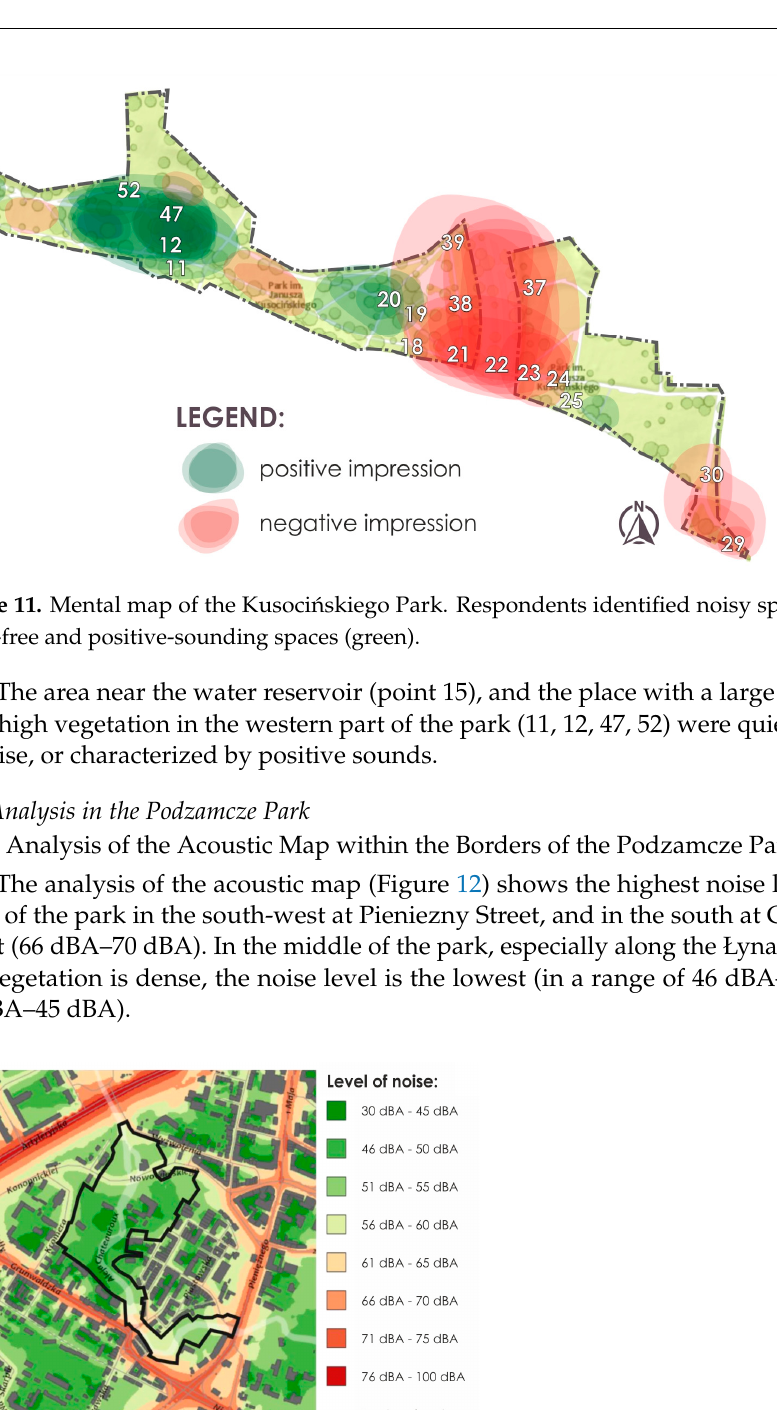
Figure 12. Acoustic map within the boundaries of the Podzamcze Park. Source: Own elaboration based on Acoustic Map of Olsztyn [93].